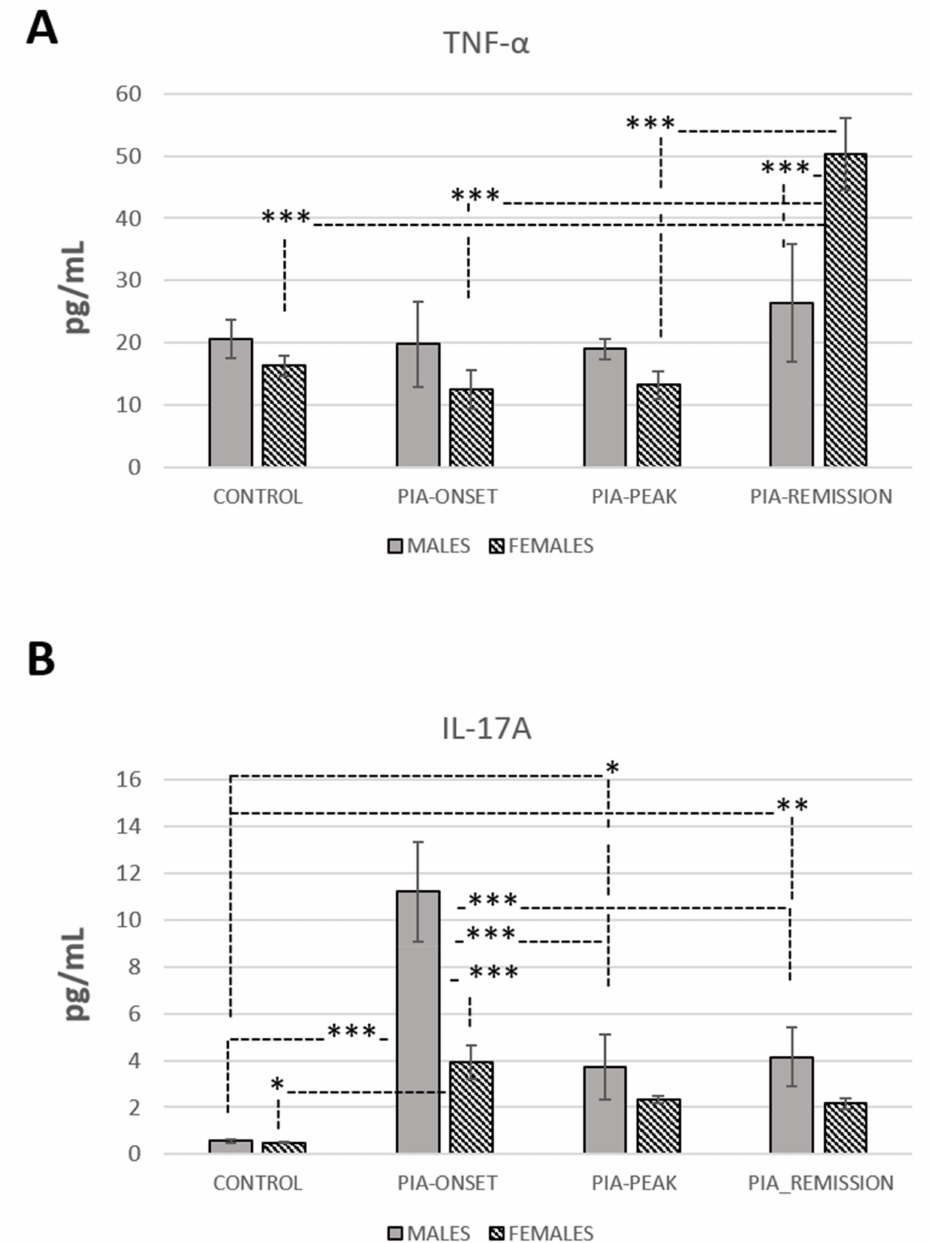
Figure 5. Expression profiles of TNF- α and IL-17A in serum during PIA. ( A ) Expression profile of TNF- α in serum. ( B ) Expression profile of IL-17A in serum. Both profiles are evaluated with ELISA in serum from male and female DA rats: control (treated with saline); PIA onset (between 9th and 12th day after induction); PIA peak (between 16th and 20th day after induction); PIA remission (between 20th and 25th day after induction). Values in pg/mL are expressed as mean ± SD (10 rats/group, N = 40). One-way ANOVA followed by the post hoc Scheff é test: * p < 0.05, ** p < 0.01, and *** p <